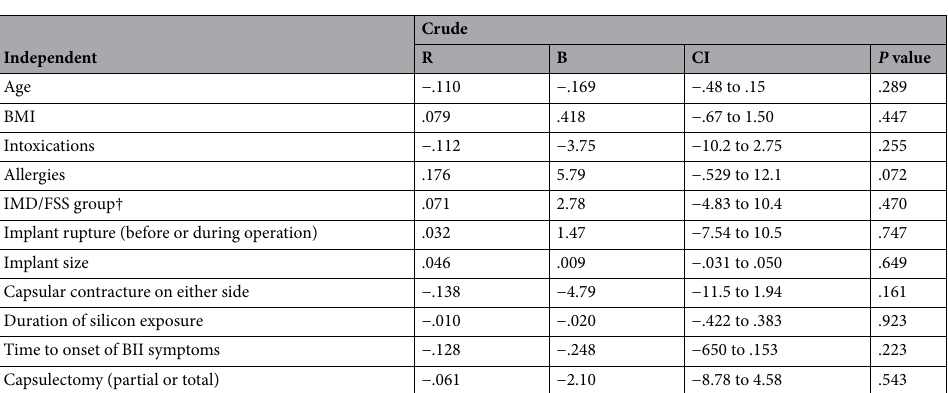
Table 6. Pearson’s or Point Biserial correlation and univariate linear regression coefficients of variables possibly affecting symptom recovery in relation to recovery of ASIA summary score*. *For population having completed both questionnaires (n = 109). R = correlation. B = regression coefficient. CI = confidence interval. †i.e. SLE, Sarcoidosis, Rheumatoid arthritis, Raynaud’s phenomenon, Lichen planus, Lichen sclerosus, Ehlers−Danlos, Vitiligo, IgA deficiency, ITP, Still’s disease, polyclonal IgM Syndrome, fibromyalgia, CFS, IBS. Dependent variable = recovery of ASIA-scale scores. R = correlation. B = regression coefficient. CI = confidence